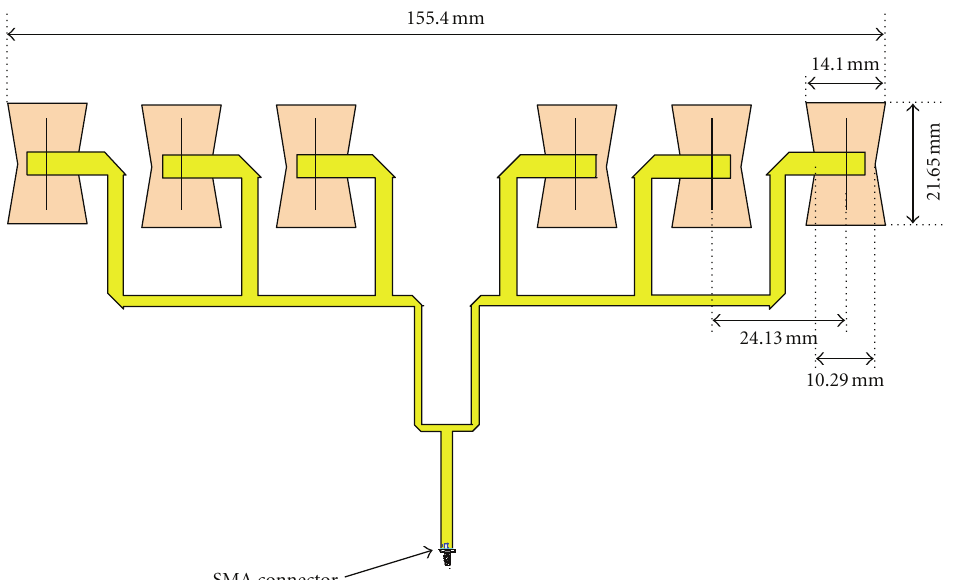
Figure 14: Mask of the multilayered bow-tie antenna array operating at the frequency 8 GHz.